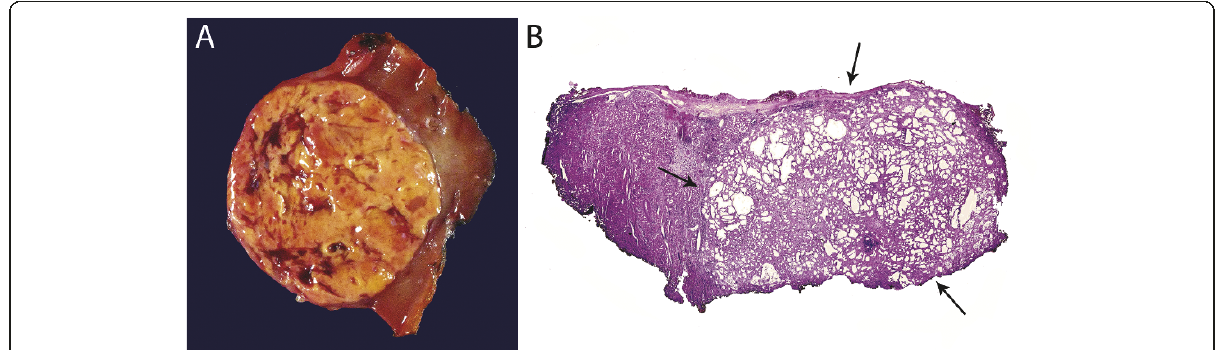
Figure 2 Gross image and full-montage of the ccRCC and TCRC, respectively. A) The larger mass was well encapsulated, tan-yellow to red and grossly suggestive of ccRCC . This lesion was not associated with the smaller nodule. B) Full-montage of the smaller lesion. The ‘ spongy ’ nodule encountered in the gross description (arrows) was composed of cystically-dilated irregular tubules of different sizes, separated by fibrovascular septae (H&E).